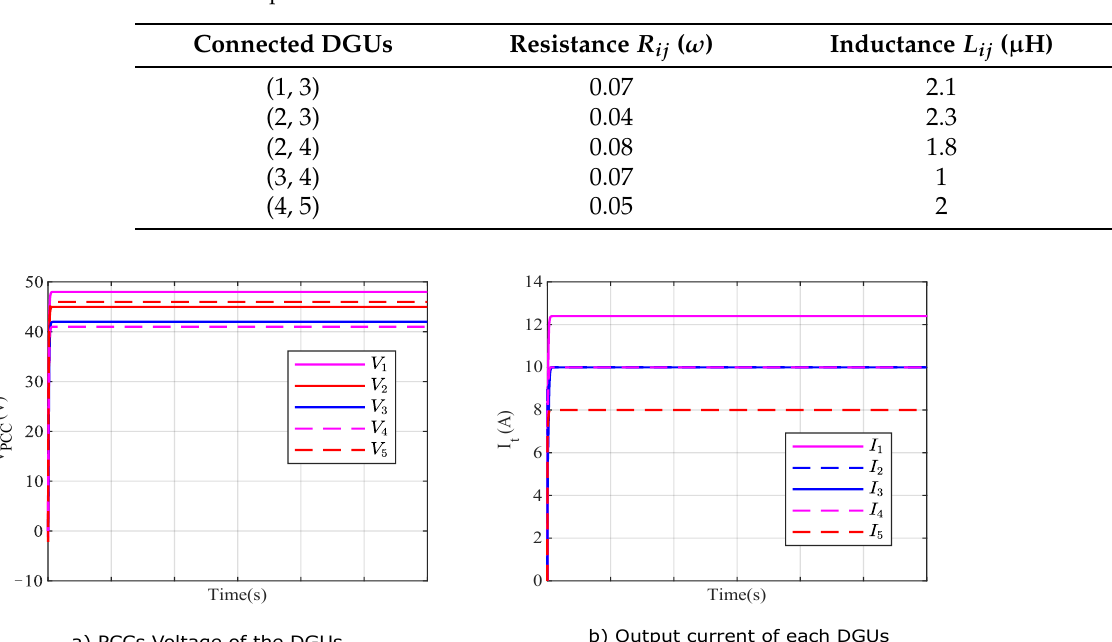
Table 2. Line parameters of the interconnected DGUs.